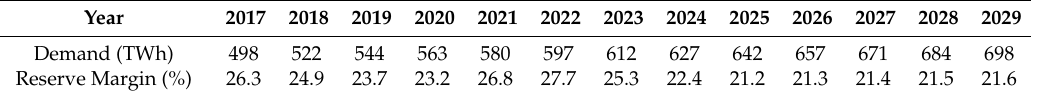
Table 3. Demand (TWh) and reserve margin (%).